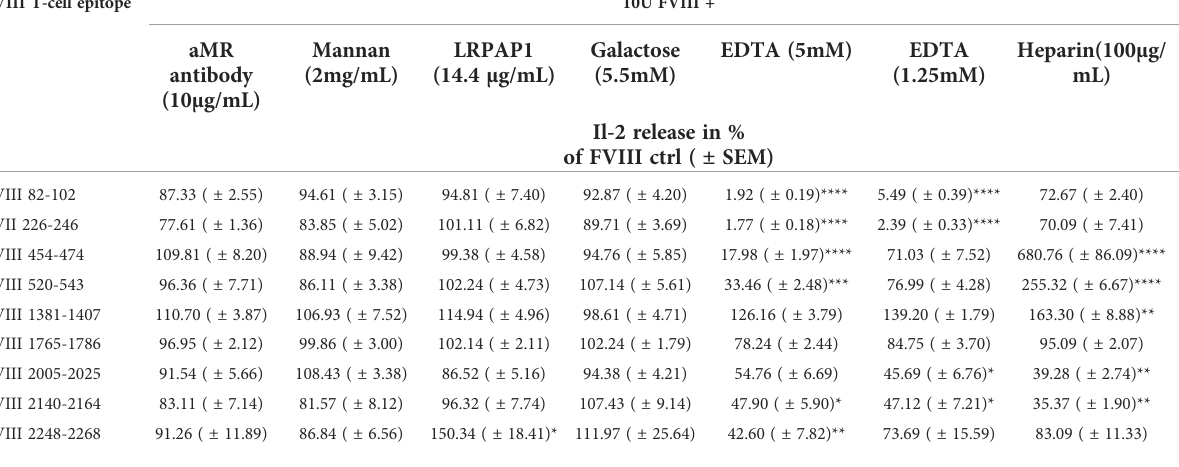
TABLE 3 In fl uence of different blocking agents for endocytosis receptors present during preincubation of APCs with FVIII, on the peptide speci fi city of subsequently activated FVIII-speci fi c CD4+ T cell hybridoma clones . FVIII T-cell